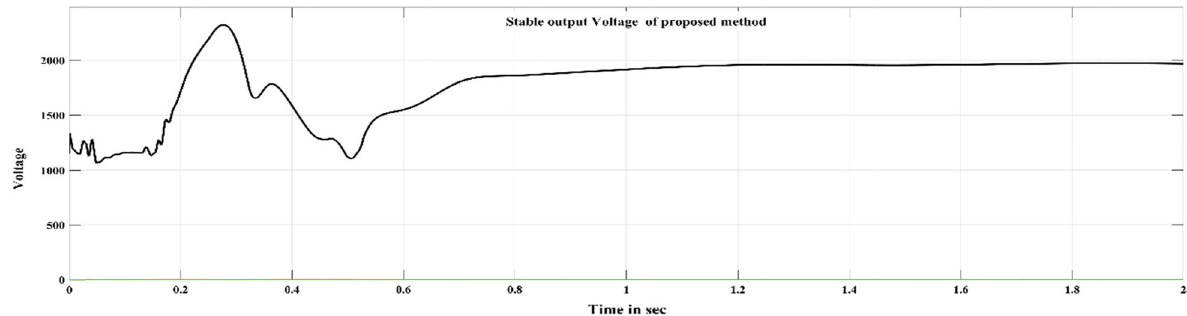
Fig. 10 Initialization of the proposed designed model